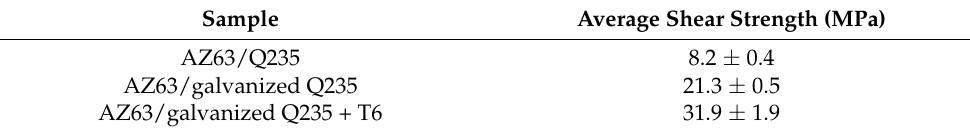
Table 4. Shear strength of AZ63/Q235 metallurgical bonding with different heat treatment times.